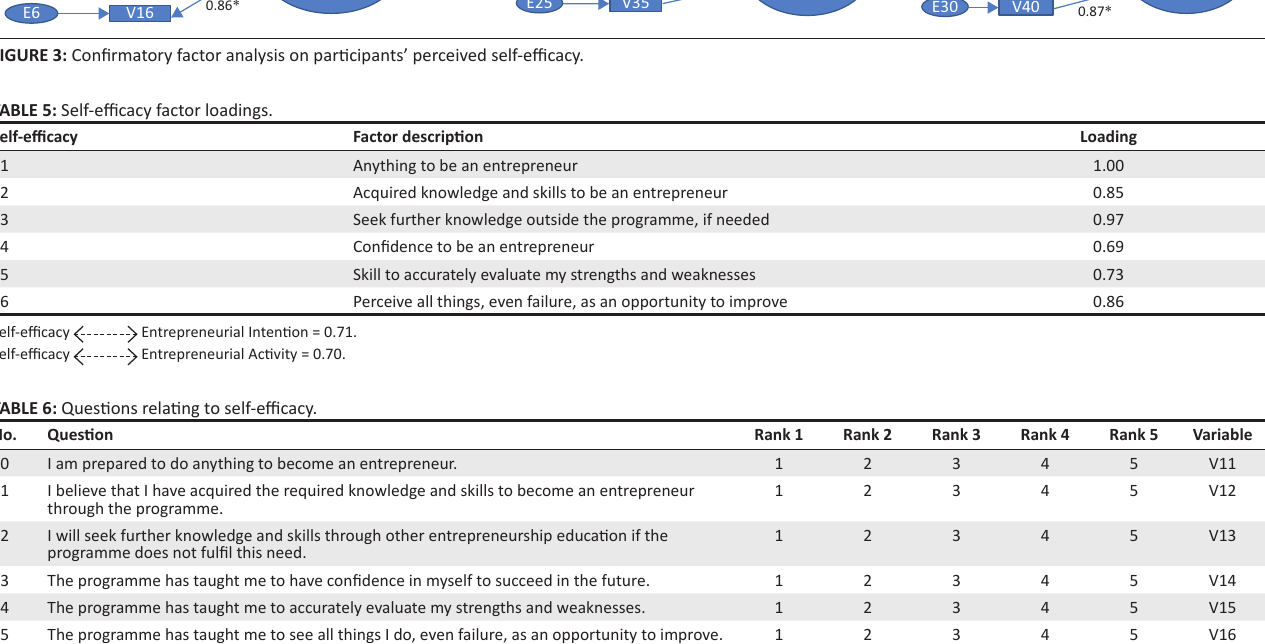
Entrepreneurial Inten(cid:19)on